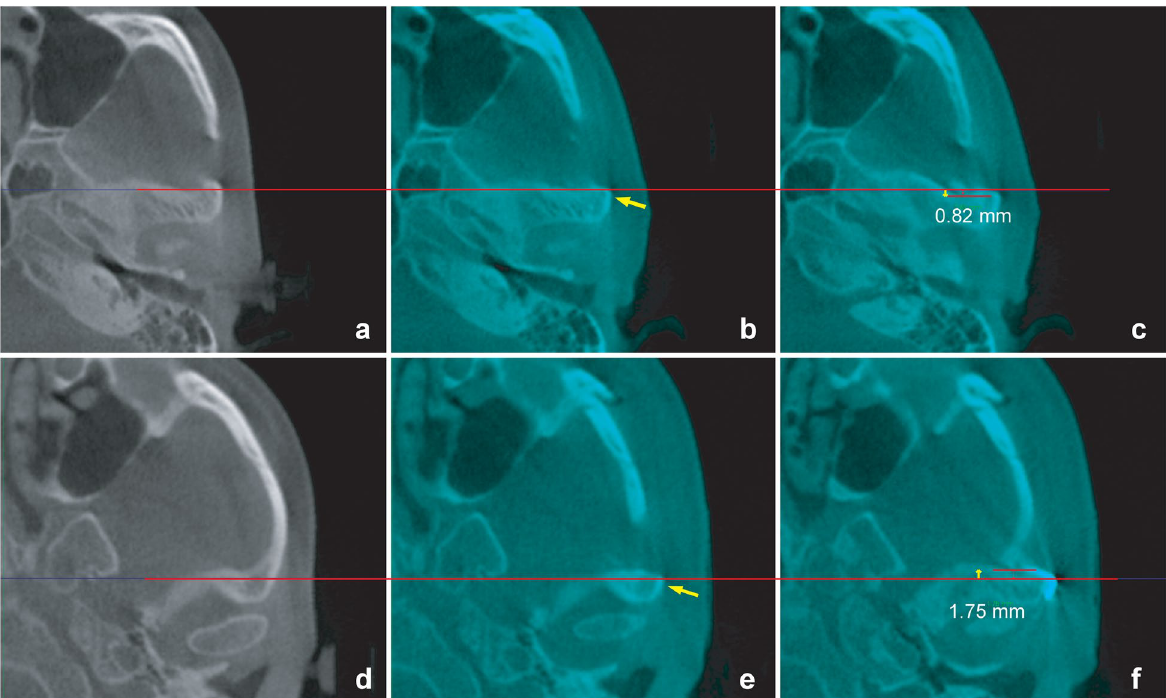
Fig. 5 Measurement of the AP movement of the arch cutting edge on axial CT images. Comparison of the preoperative images ( a and d ) with the postoperative images ( b and e ) at the same level. The lateral cutting edge of the temporal bone is shown in the lowermost axial plane (yellow arrows in b and c ). The cutting edge of the arch moved inward. When the cut edge moved posteriorly, a negative value was assigned; when it moved anteriorly, a positive value was assigned. The red line indicates the cutting edge baseline of the temporal bone. c and f show backward and forward movements of the arch, respectively